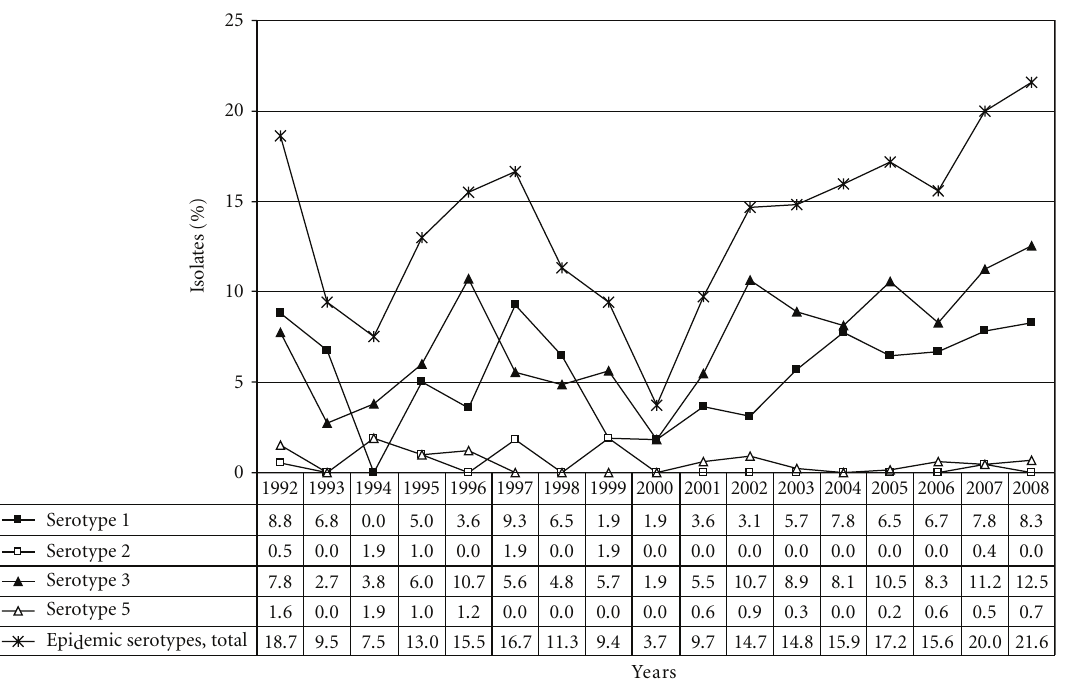
Figure 1: (a) Distribution of the epidemic serotypes 1, 2, 3, and 5 in percent (1992–2008, n = 9,394) in all age groups. (b) Distribution of the epidemic serotypes 1–3 and 5 among children in percent (1992–2008, n = 2,948). (c) Distribution of the epidemic serotypes 1–3 and 5 among adults in percent (1992–2008, n =